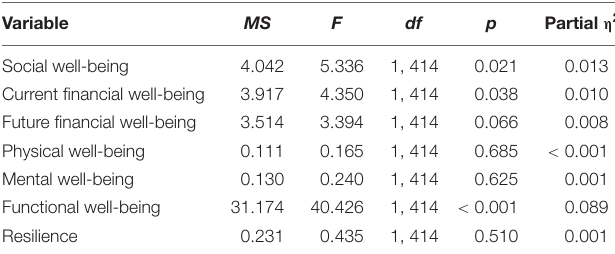
TABLE 7 | Effects of stay-at-home orders on resilience and well-being, whilst controlling for gender, age, income and #new covid infections per 100k